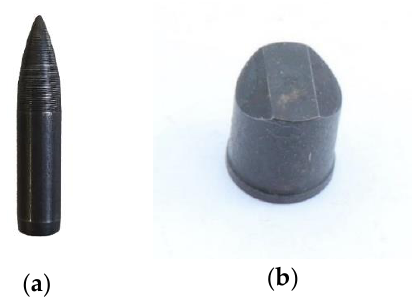
Figure 2. ( a ) Projectile M352 7.62 × 51 AP. ( b ) Projectile 7.62 FSP.